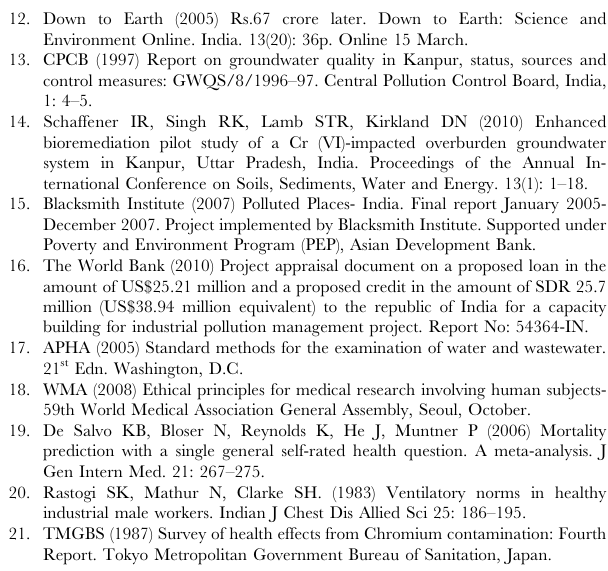
Figure S1 Photographs showing dermatological prob- lems among subjects exposed to hexavalent chromium contaminated groundwater. Table S1 Various self-reported health complaints in- cluded in the